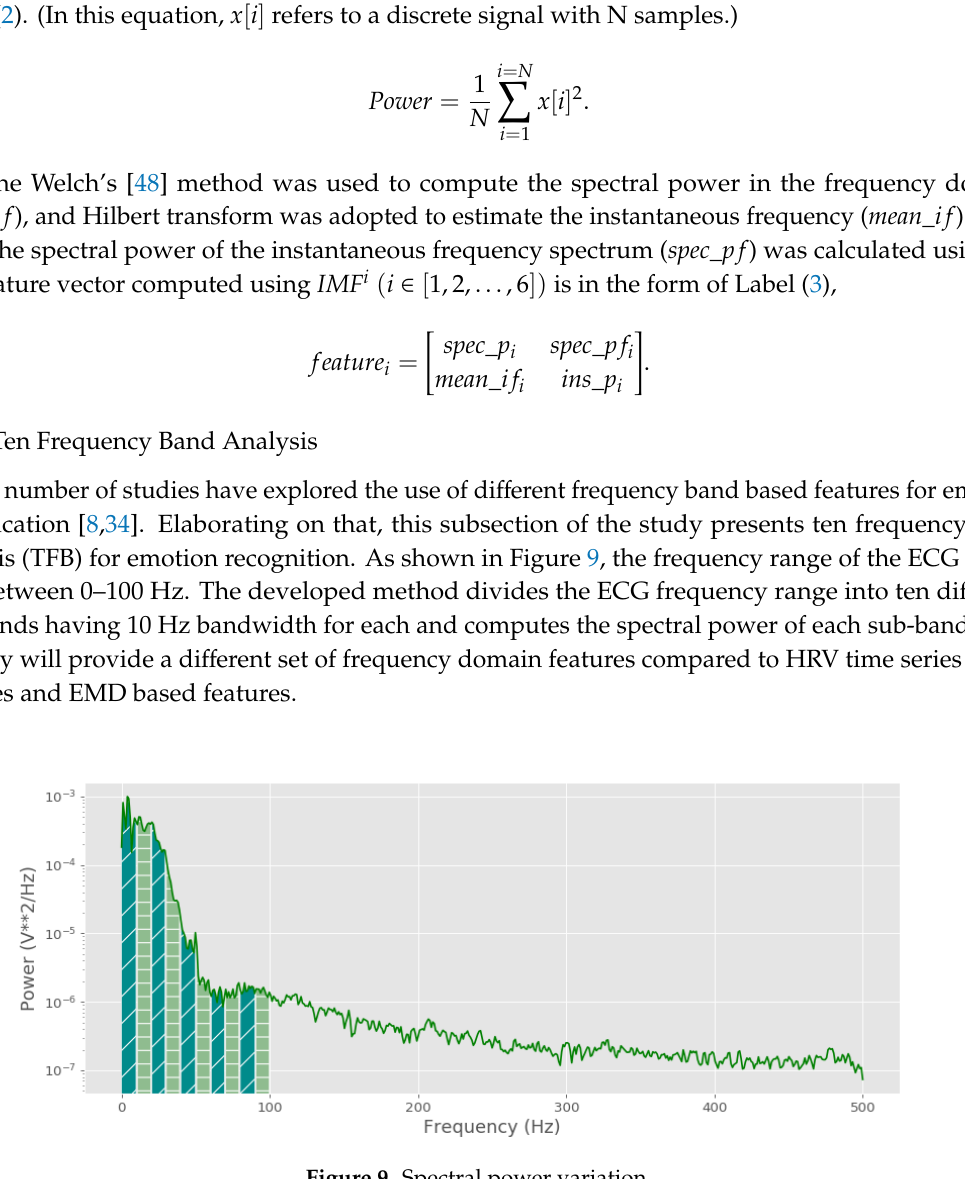
Figure 9. Spectral power